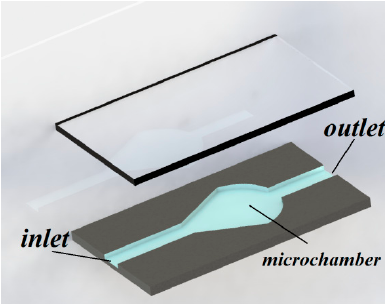
Figure 1. Isometric view of pear-shaped microchamber applied to decrease the fluid shear stress on cells. Reproduced after [78].